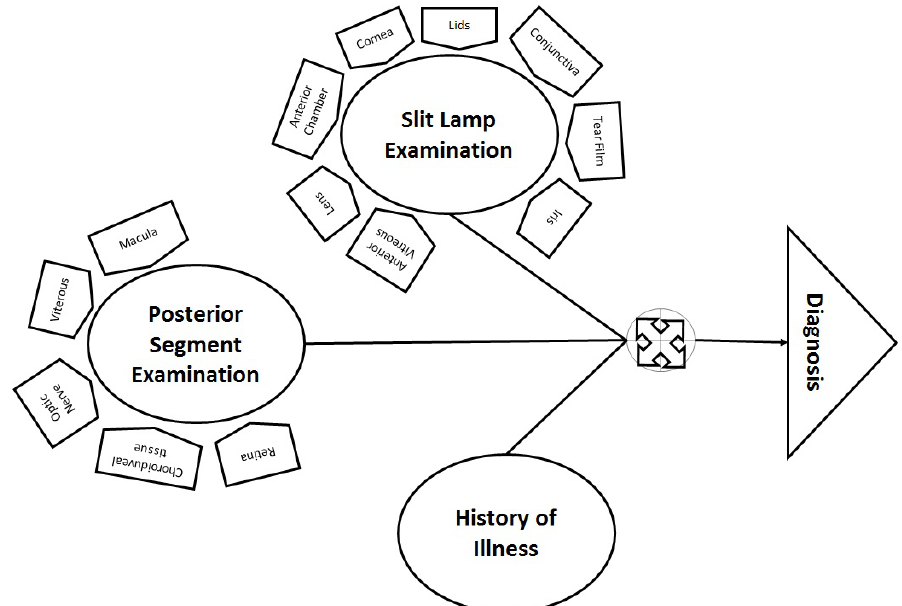
Figure 1. Eye disease diagnosis mechanism.